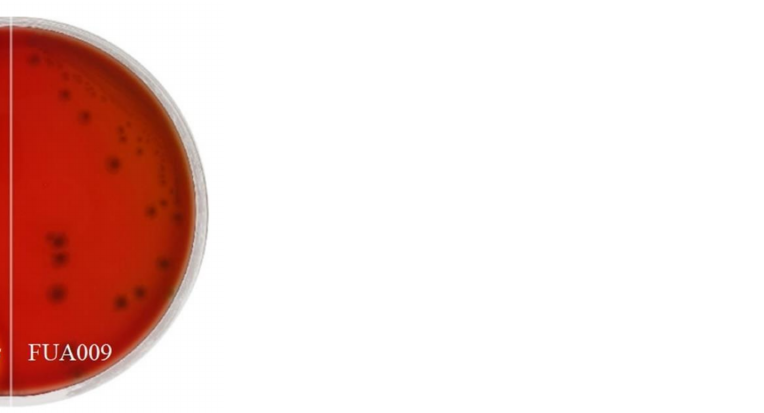
Figure 3. Lactococcus garvieae FUA009 did not show any hemolysis ability on the blood agar